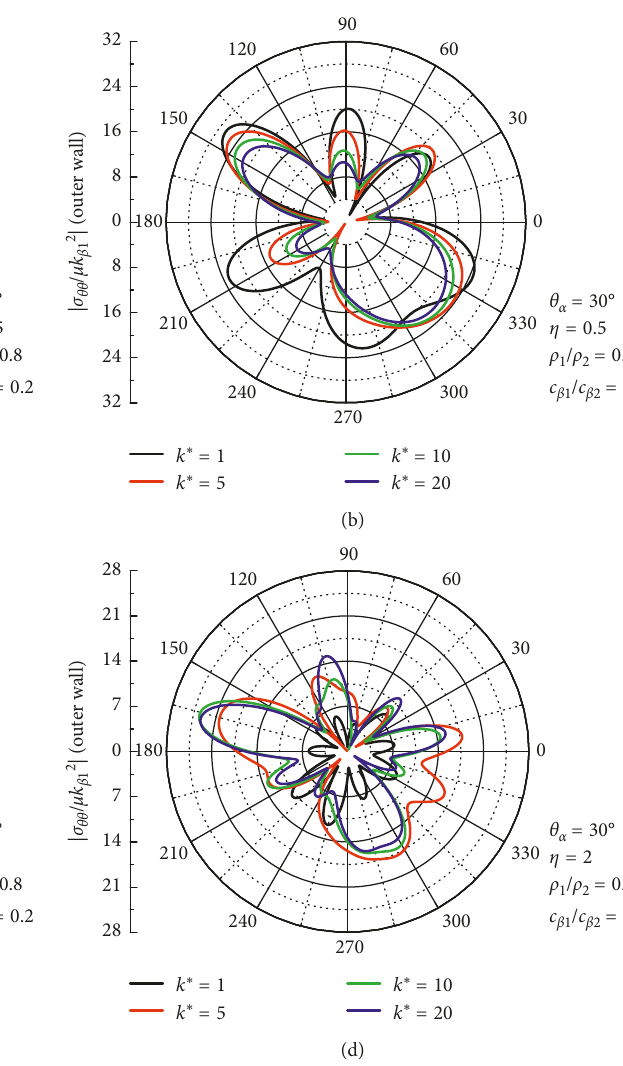
° ): (a) η 0 . 25; (b) η 0 . 5; (c) η 1; (d) η α (cid:29) 30 (cid:29) (cid:29) (cid:29) (cid:29)